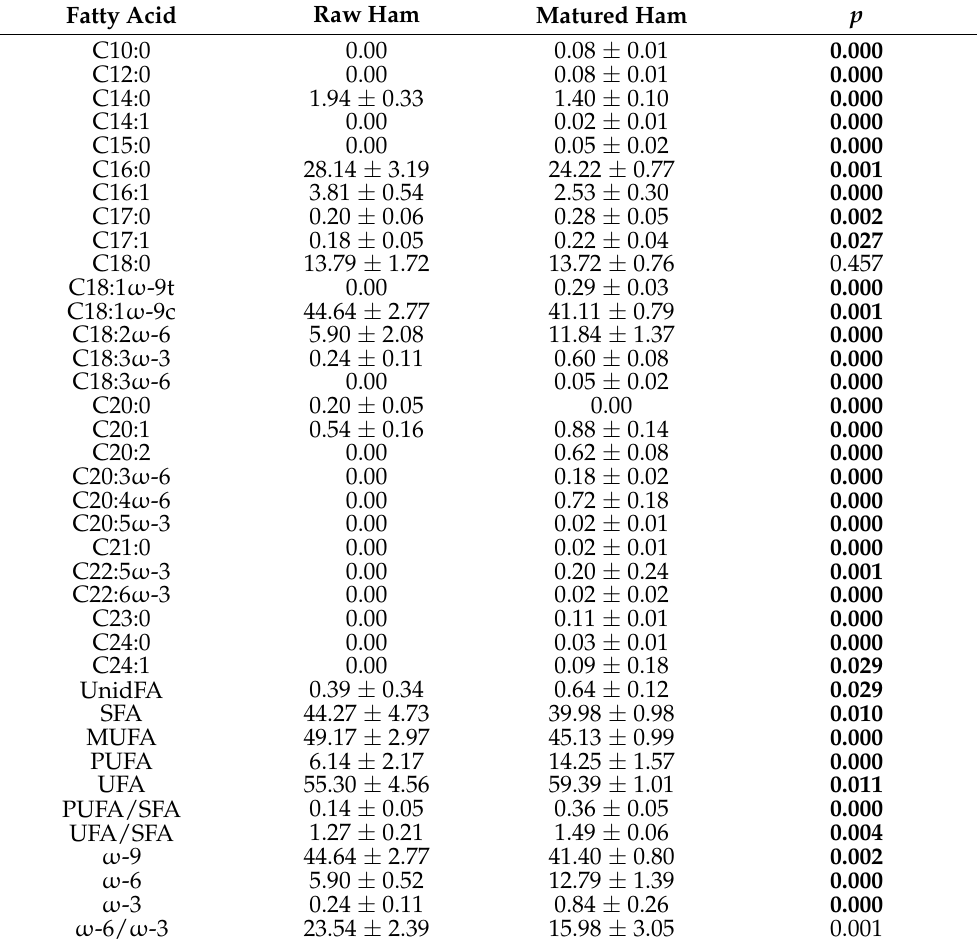
Table 4. Influence of processing on the FA composition (means ± standard error) of raw and matured Istarski pršut of (LWxL)xD genotype (% of FAMEs). Fatty Acid Raw Ham Matured